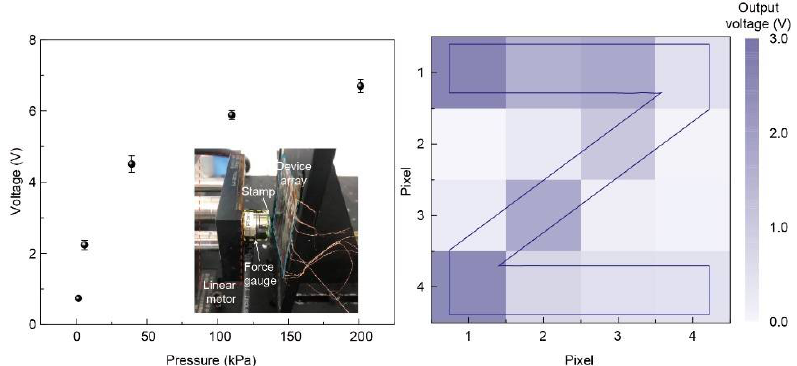
Figure 5. Left : output voltage of a single pixel as a function of the applied pressure. The inset shows the experimental setup to apply and measure the pressure sensing. Right : the pressure mapping result of the “Z” shaped stamp with output voltage signals, in which pixels contacted with the stamp ridge area show a higher output.